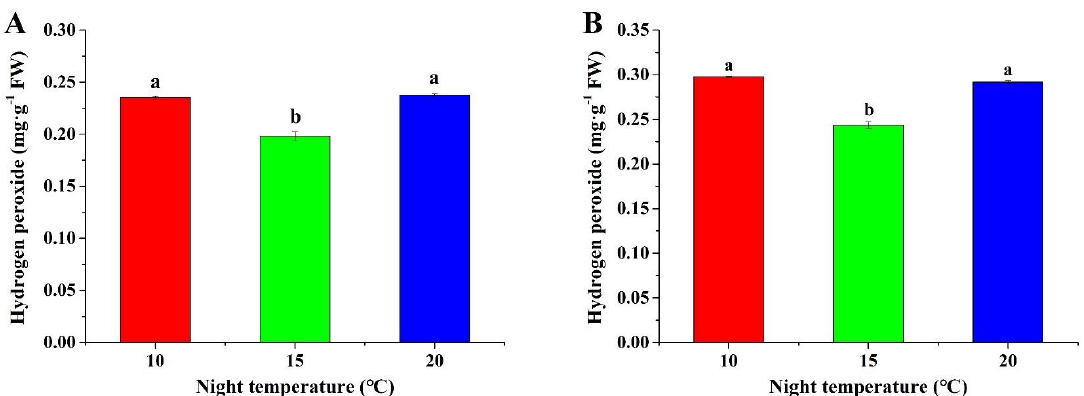
Figure 3. Effect of night temperature on the hydrogen peroxide content in A. membranaceus ( A ) and C. lanceolata ( B ) plug seedlings. Data are presented as the mean ± standard error (n = 3). Different letters (a and b) indicate significant differences among treatments by Duncan’s multiple range test at a 0.05 level.